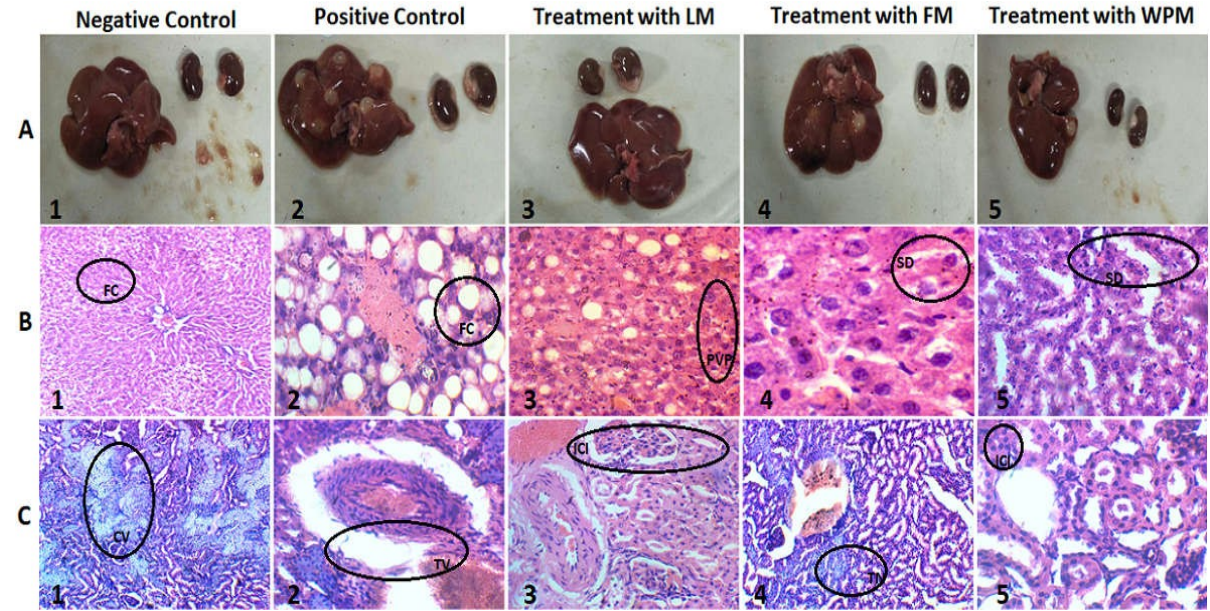
Figure 1. Effect of P. stewartii Hf. plant extract on; ( A ) liver morphology, ( B ) liver histology and ( C ) renal histology